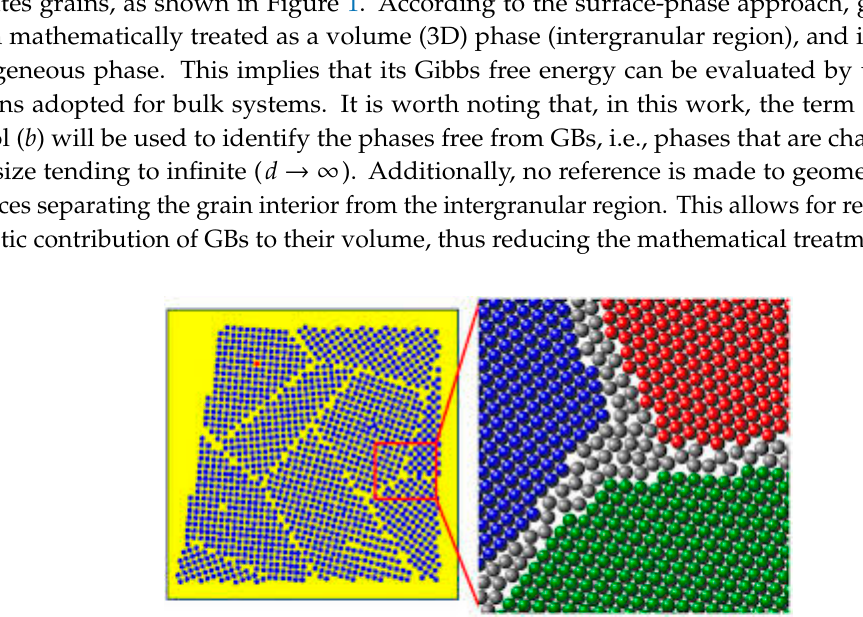
Figure 1. Representation of multi crystalline solutions (colored areas) system with intergranular regions of a finite volume (white area).